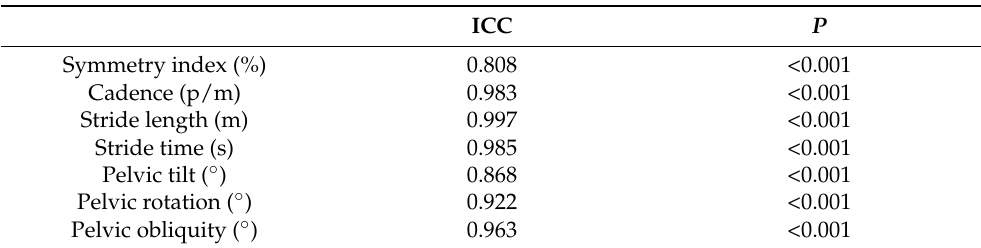
Table 3. Reliability index for the IMU sensor according to spatiotemporal outcomes, pelvic kinematics, and symmetry index. ICC